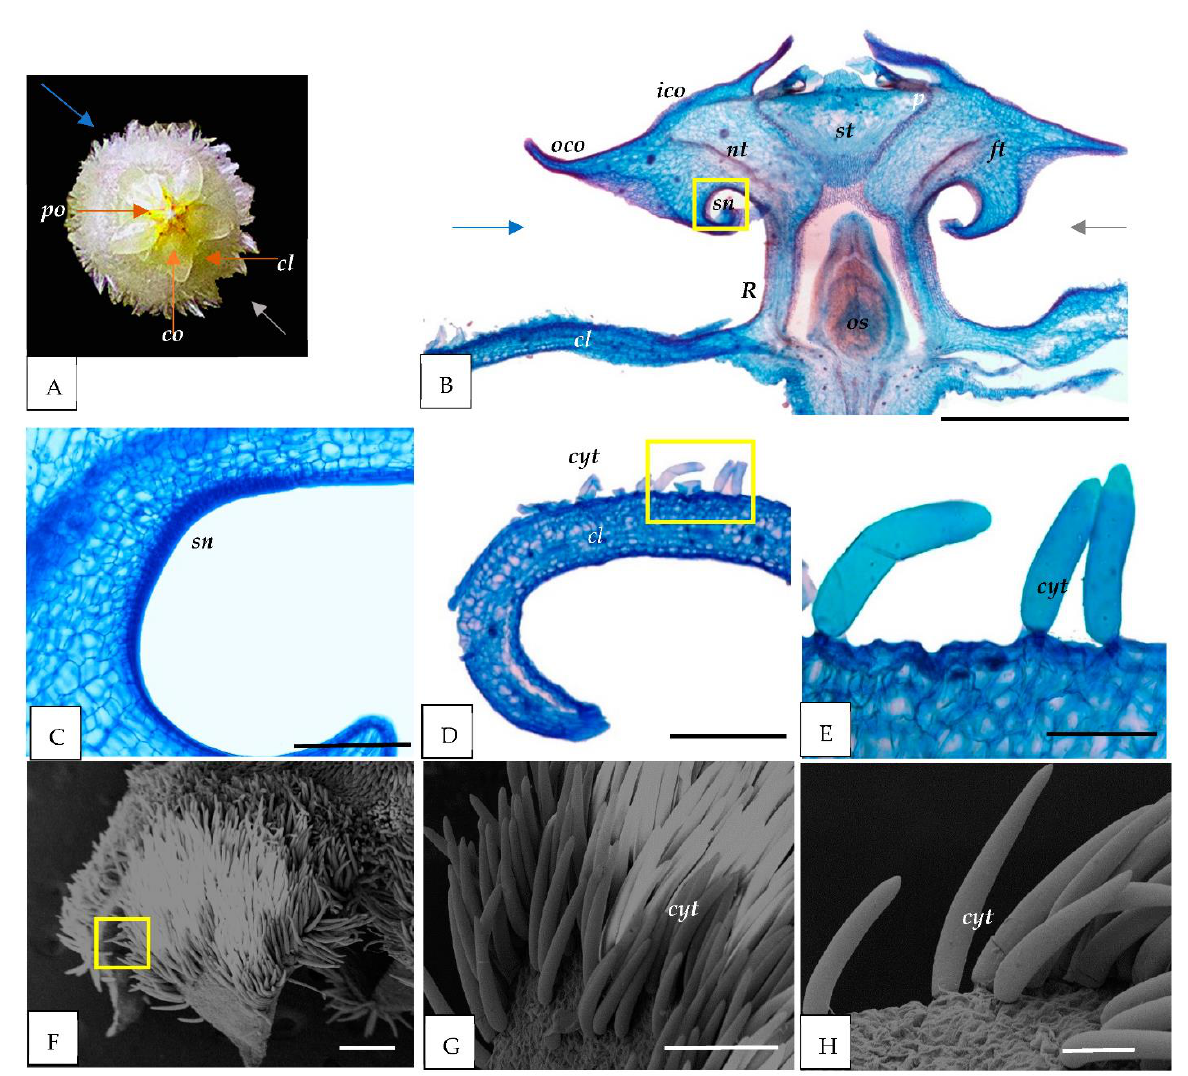
( cyt ) with an average width of 31 µ m and an average height of 233 µ m (Figure 2E,H). For H. coriacea , the trichomes are unicellular, falcate ( ft ) with various sizes with an average width of 57 µ m and height of 440 µ m (Figure 3E,H). All trichomes in this study were observed to have a smooth surface.